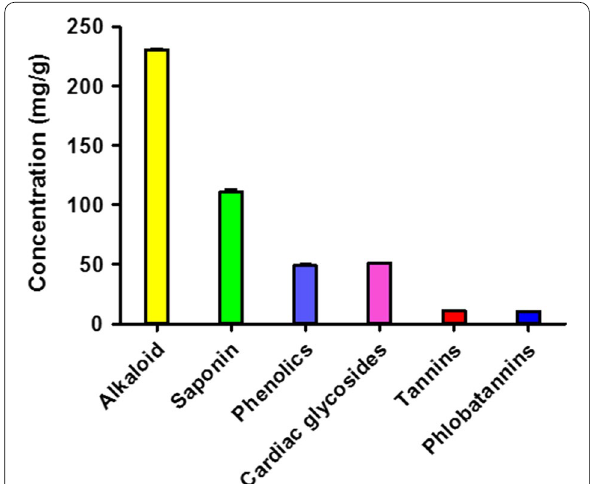
Fig. 2 Phytochemical contents of aqueous extract of B. sapida